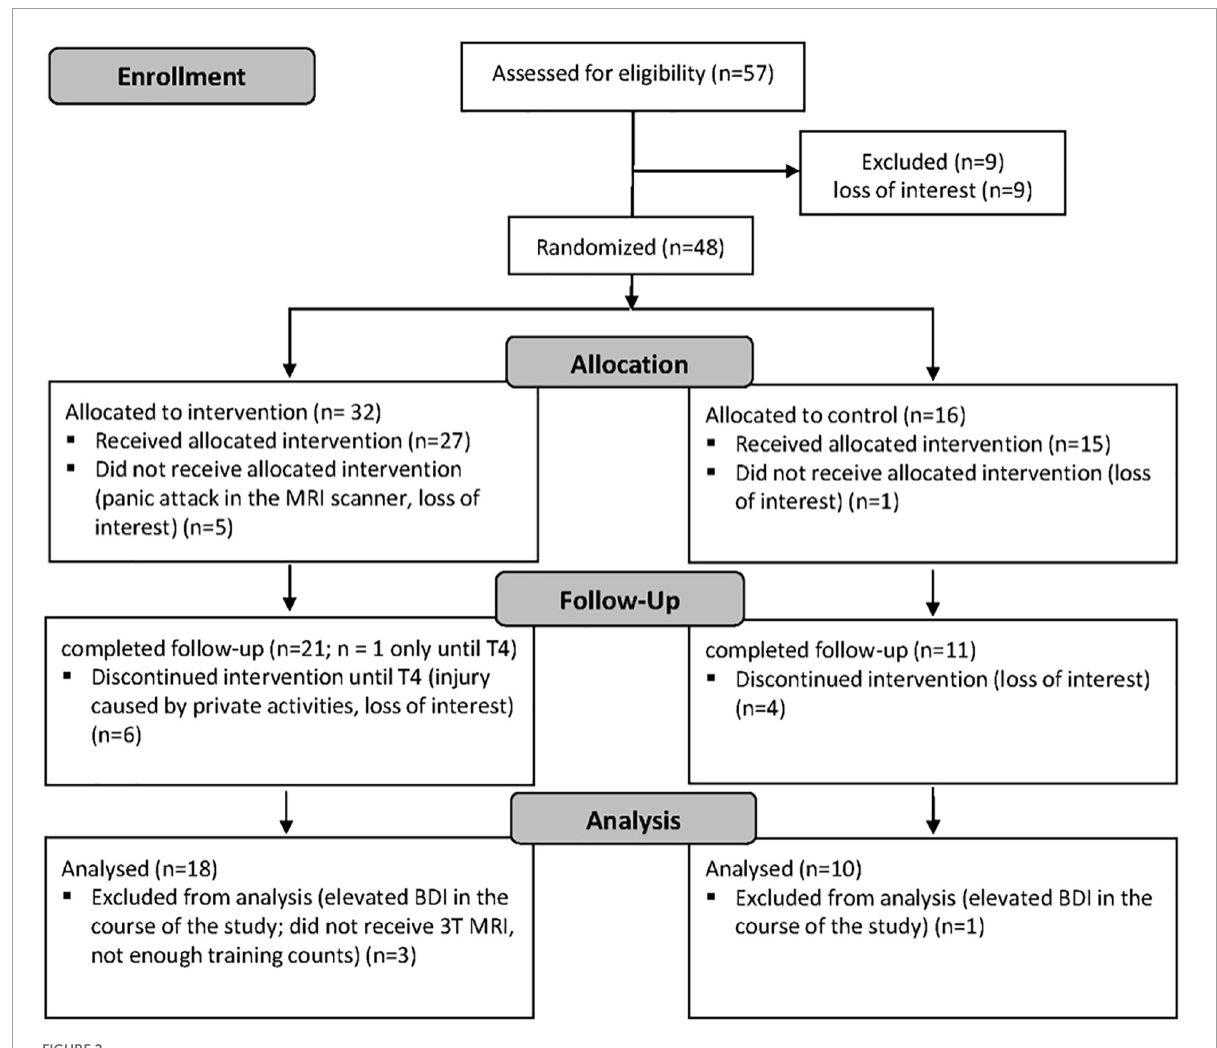
FIGURE2 Flow chart diagram. T4, examination timepoint after 4